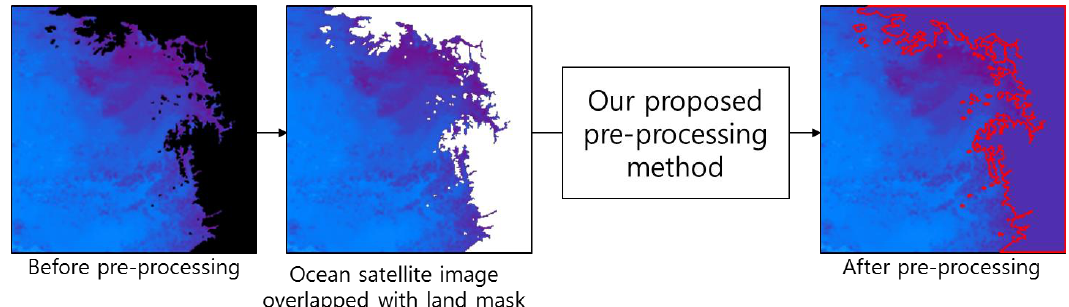
Figure 2. Illustration of the proposed preprocessing approach where every pixel value in the land area is replaced by the average of the RGB pixel values of the ocean surface area.